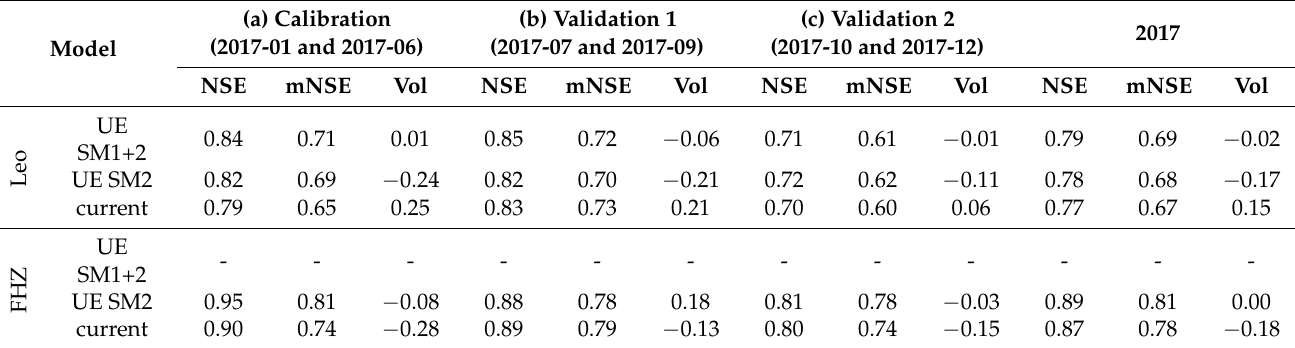
Table 11. Performance criteria of the different models for the green roofs “Leo” and “FHZ”. The analysis was done with a daily timestep.